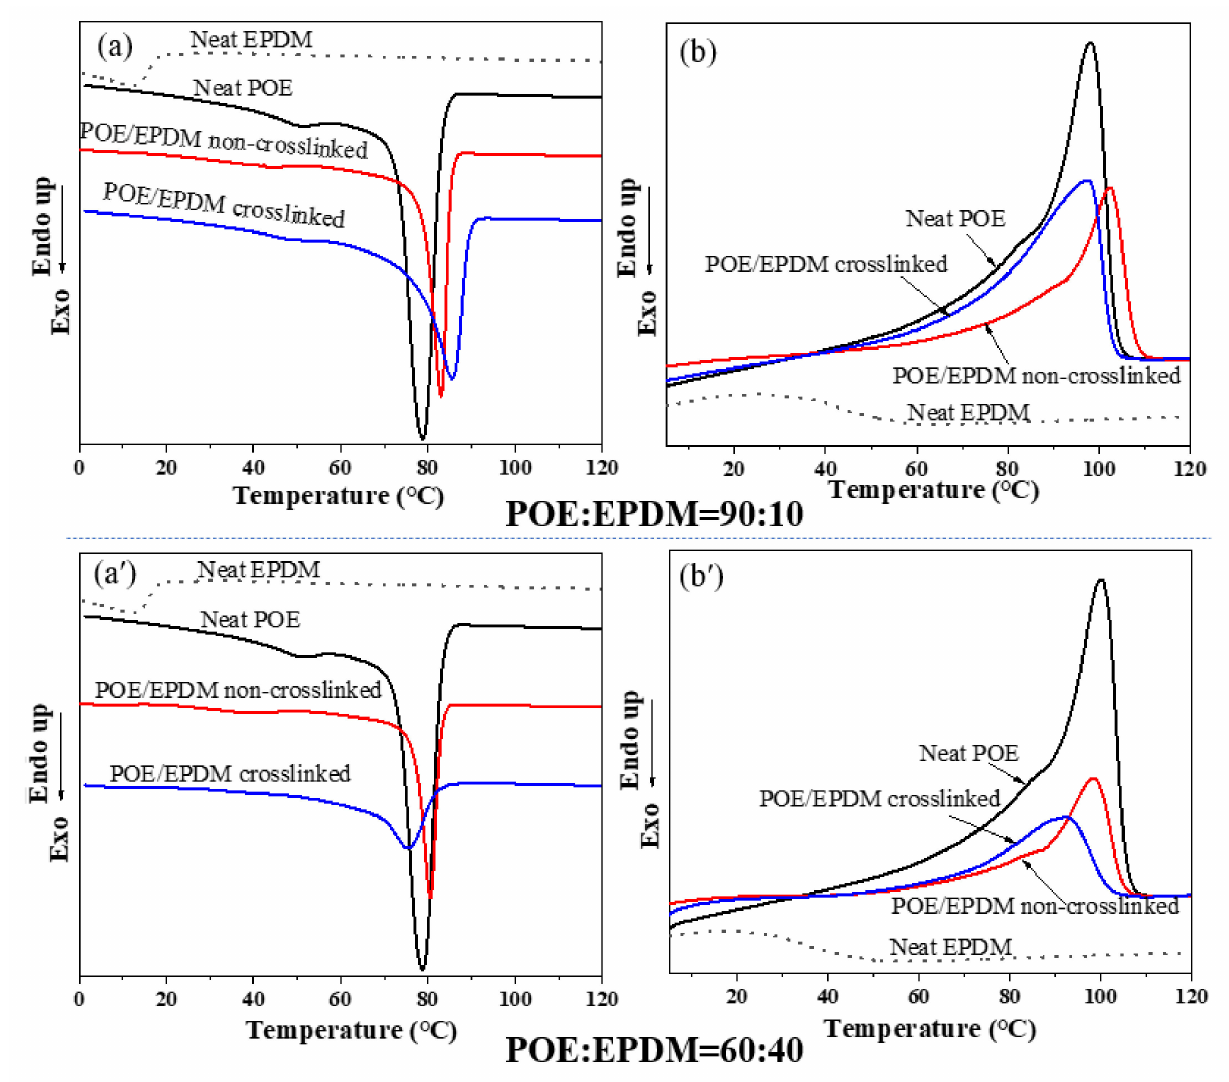
Figure 2. DSC cooling (10 ◦ C/min) thermograms and the subsequent melting (10 ◦ C/min) thermo- grams of neat POE, neat EPDM, dynamic crosslinked POE/EPDM, and non-crosslinked POE/EPDM: ( a , a (cid:48) ) cooling thermograms; ( b , b (cid:48) ) the subsequent melting thermograms. Crosslinked blends show lower melting temperature, indicating that the crystals are